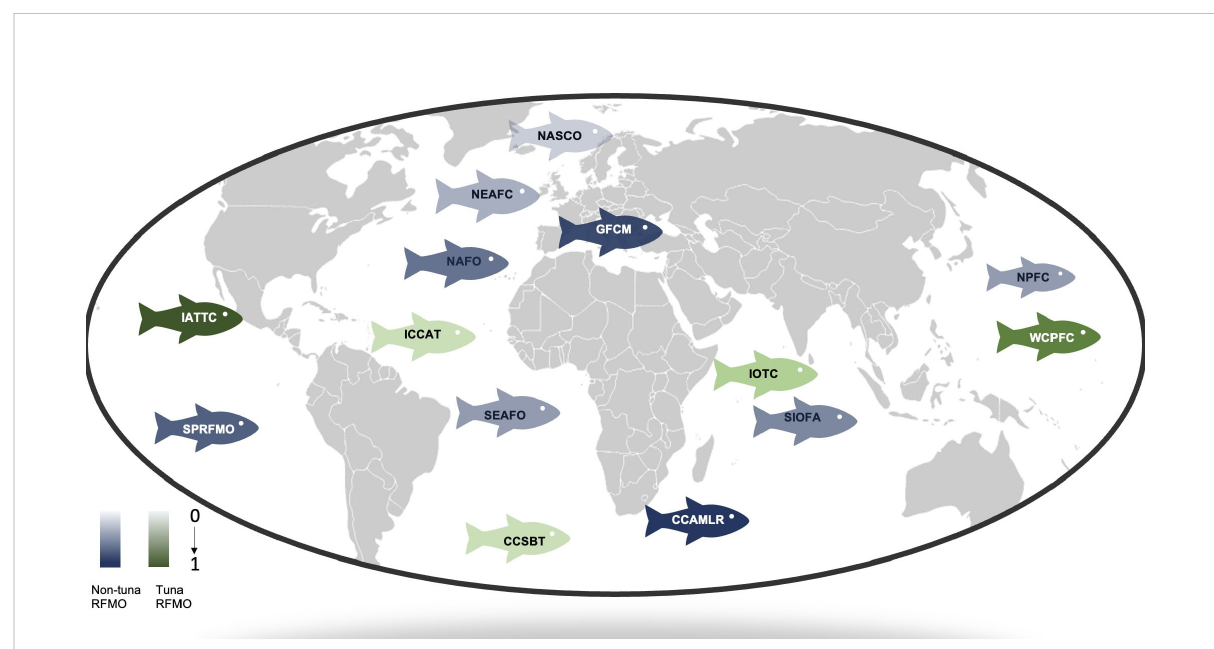
FIGURE 3 Overall RFMO score based on the analysis of 25 questions; a darker fi sh icon represents a higher average score for tuna RFMOs (green) and non-tuna RFMOs (blue), respectively.